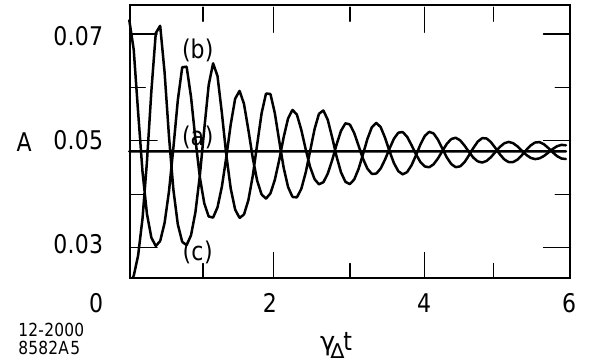
FIG. 5. Beam dynamics in the vicinity of the single mode FP. Resonance n 0 (cid:1) 1 , l 0 (cid:1) 2 2 , linear growth rate Im (cid:4) n (cid:5) (cid:1) 0.0025 , SR damping rate g d (cid:1) 2.92 3 10 2 5 . Initial condition d (cid:1) d 0 is given by Eq. (35). Three curves correspond to initial amplitudes (a) A (cid:1) A 0 , (b) A (cid:1) 1.5 A 0 , and (c) A (cid:1) 0.5 A 0